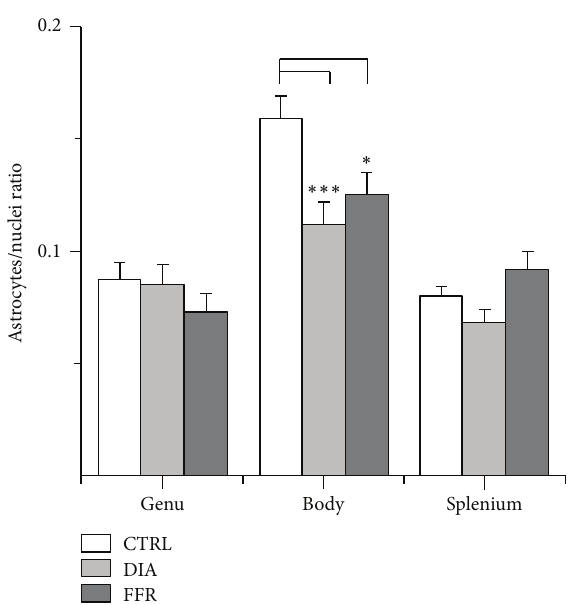
Figure 4: Astrocyte/glial cell ratio is reduced in the body of the DIA and FFR groups. The astrocyte/nuclei ratio was significantly reduced in both the dehydration-induced anorexia (DIA) and forced food-restricted (FFR) groups only in the body of the CC ( − 57.5% and − 22%, resp.) ( 𝑛 ≥ 26 ). The genu ( 𝑛 ≥ 23 ) and splenium ( 𝑛 ≥ 26 ) were not significantly affected. Data are mean ± S.E.M. ( ∗∗∗ 𝑃 < 0.001 ; ∗ 𝑃 < 0.05 ).